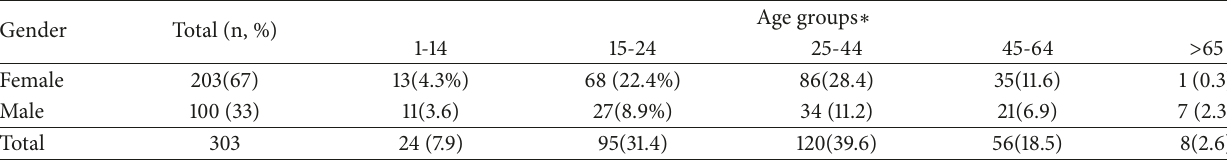
Table 1: Demographic characteristics of study participants (n= 303].